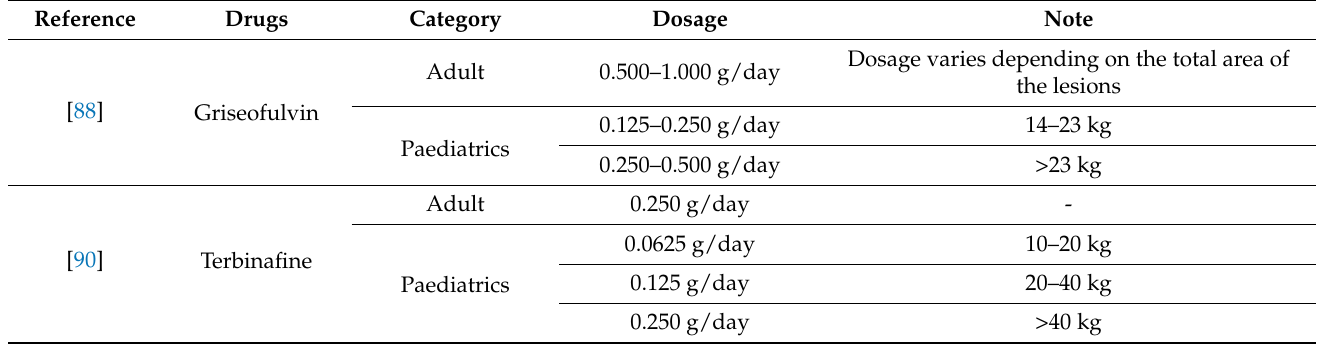
Table A1. Dosage of griseofulvin and terbinafine in the treatment of tinea imbricata.